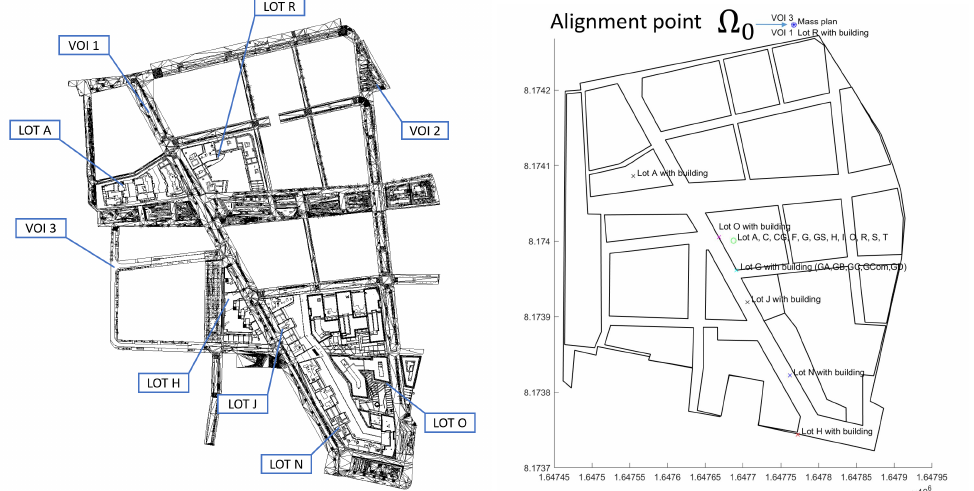
Figure 8. Left: Phase 1 of LaVallée on Revit with its parcels (lot), buildings and the road network (VOI). Right: absolute reference points of the parcels and the streets.